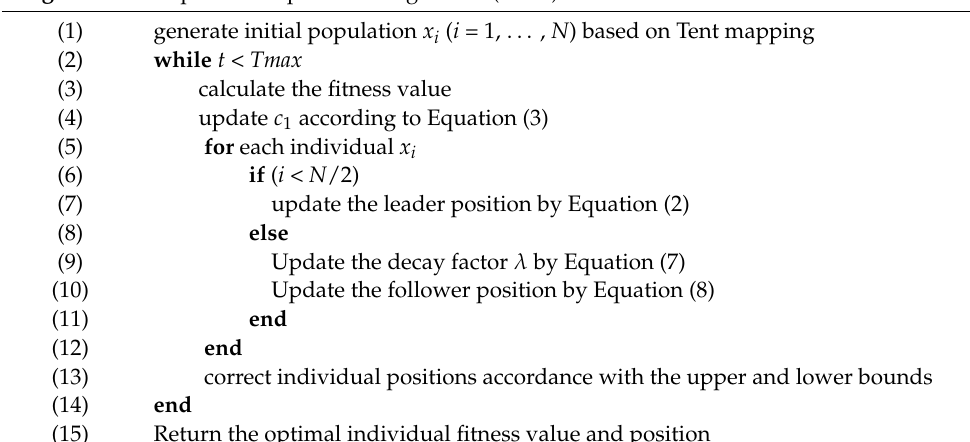
Algorithm 1: Improved Salp Swarm Algorithm